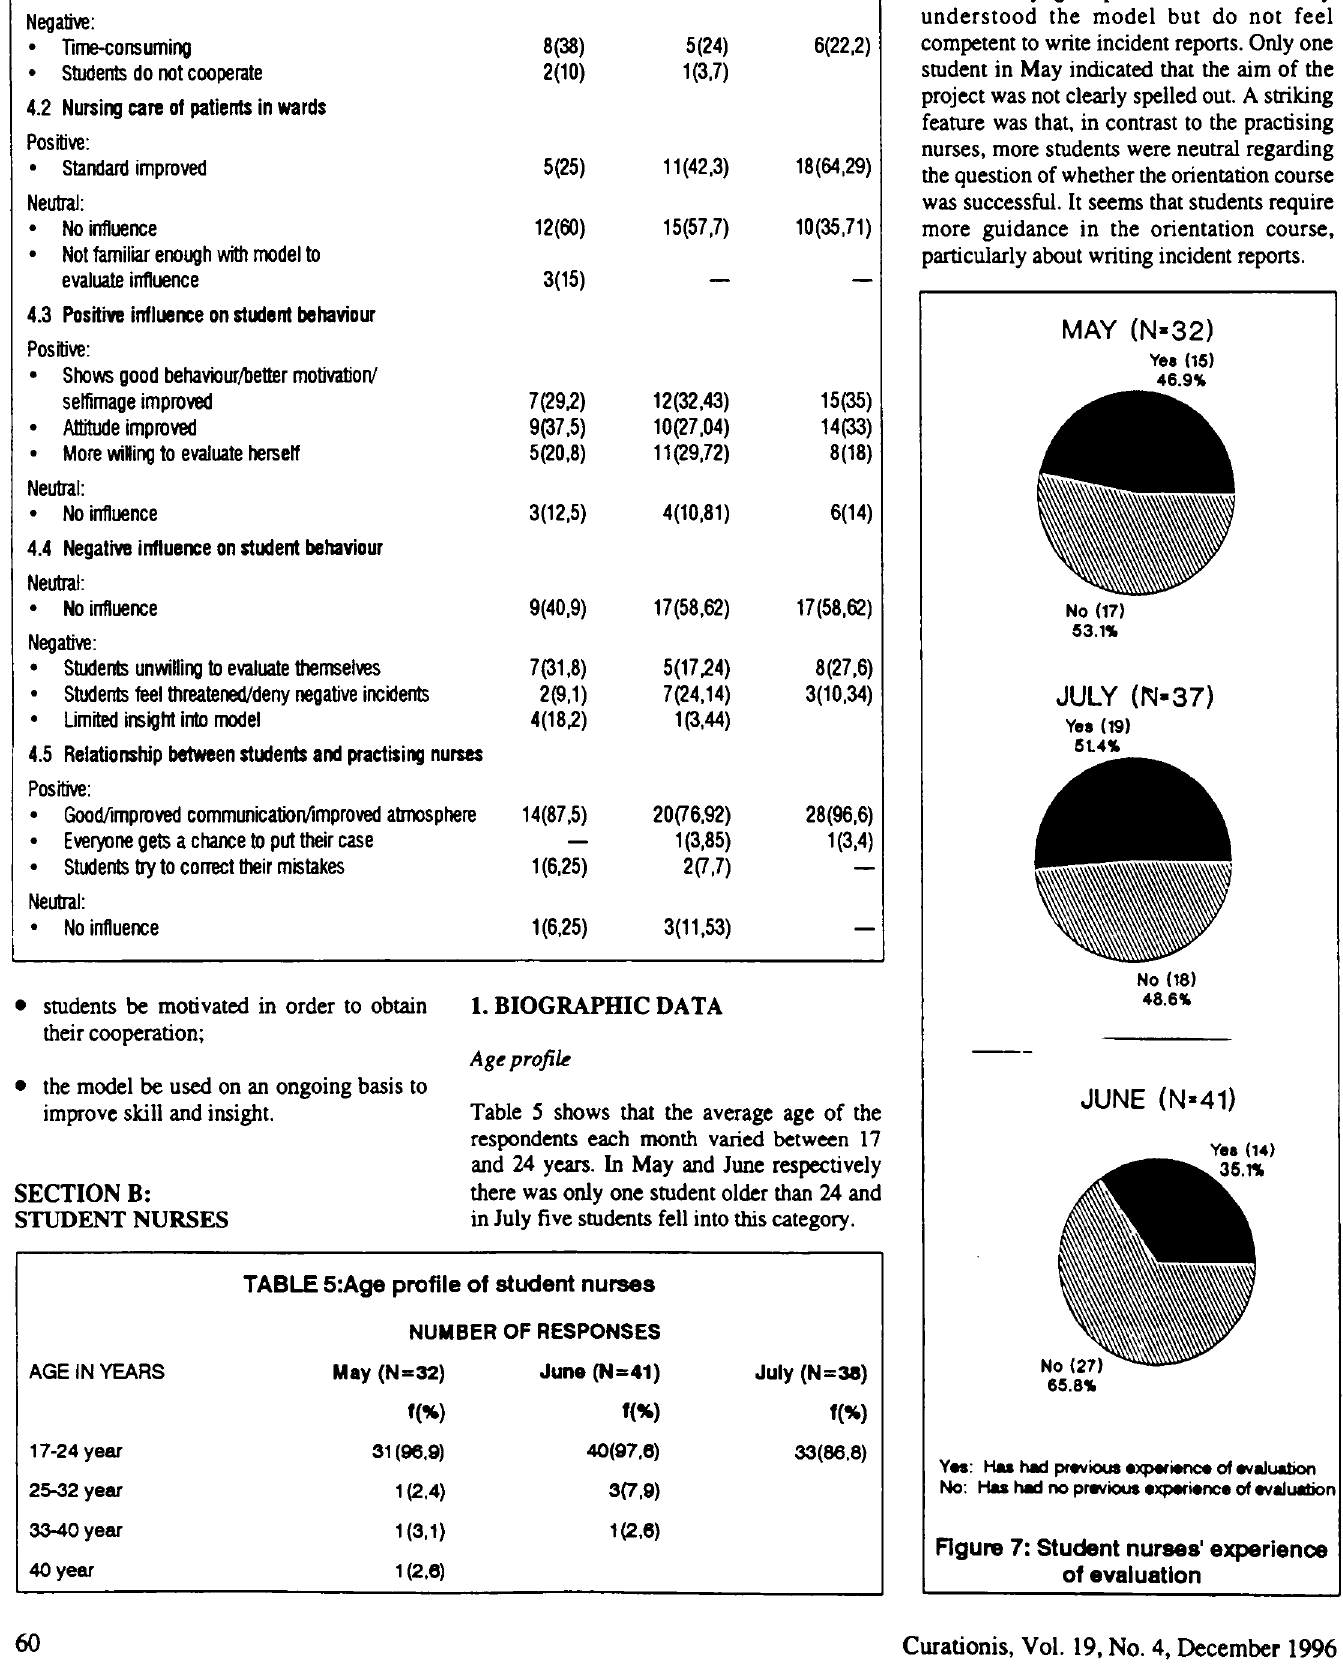
NUMBER OF RESPONSES